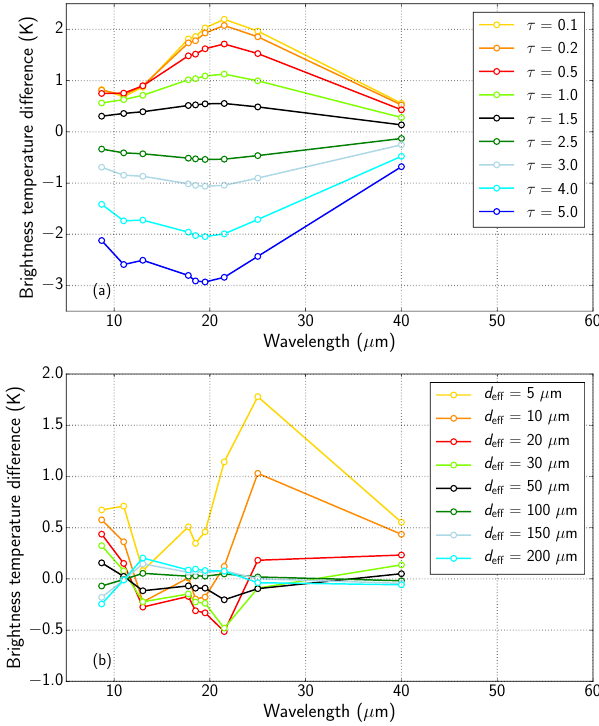
Figure 15. TOA brightness temperature differences between var- ious clouds and the reference with τ = 2 ( τ = 3 for panel b ) and d eff = 80µm. Panel (a) is for varying optical depth while panel (b) is for varying particle effective